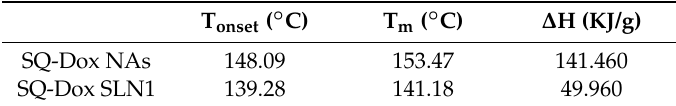
Table 2. Thermodynamic data determined from the DSC of the NAs and SLNs. T onset ( ◦ C)